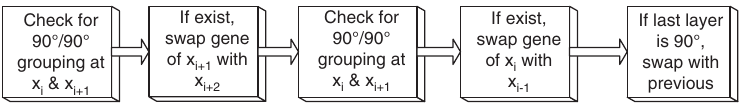
Figure 3 Execution process of replacement approach for rule 1.